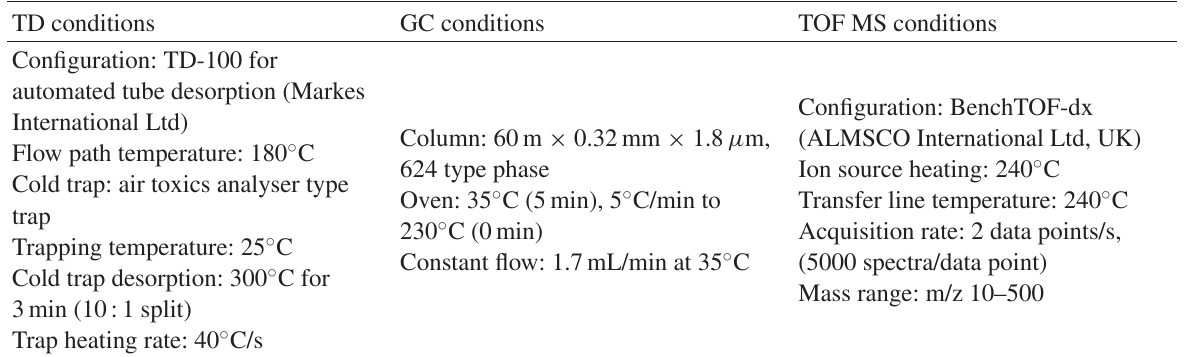
TABLE 9: Sampling and analytical